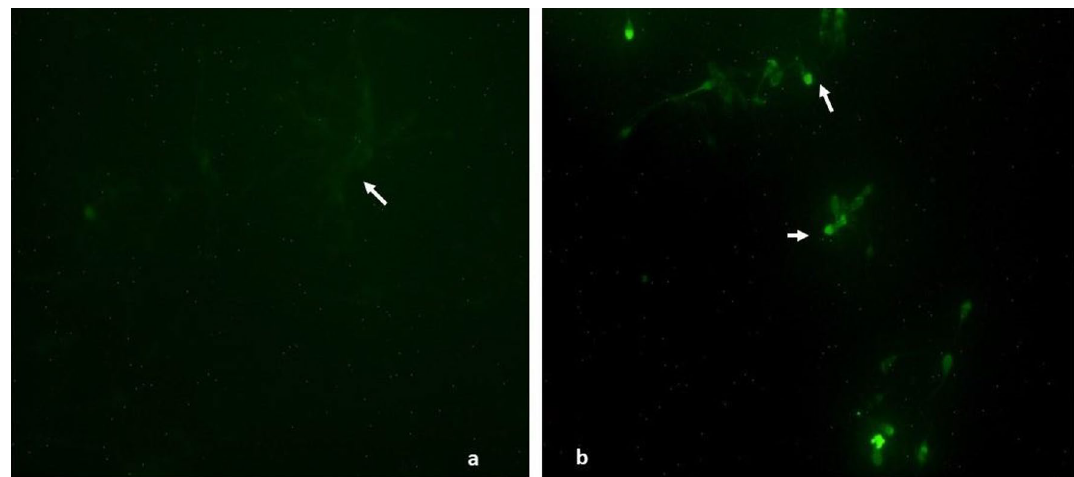
Figure 3. DNA damage in goats’ spermatozoa. ( a ) Showing no-fluorescence in spermatozoa (TUNEL-negative) in PBS control and 0.031, 1.25 and 0.25 µg/ml HgCl 2 groups after 3 h. ( b ) Showing bright green-fluorescence in head of the spermatozoa (TUNEL-positive; arrow) of mercuric chloride (1.25 µg/ml) treated group after 3 h of